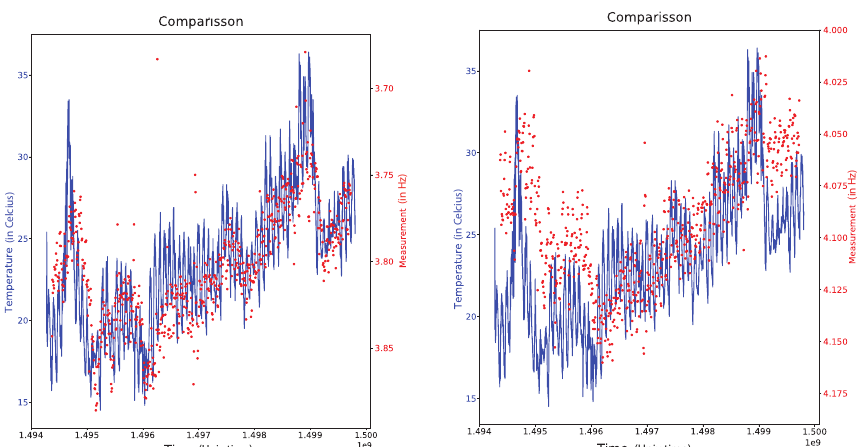
Figure 4. Comparison between the ∆ ν measurement and the temperature for the first ( left ) and second ( right )